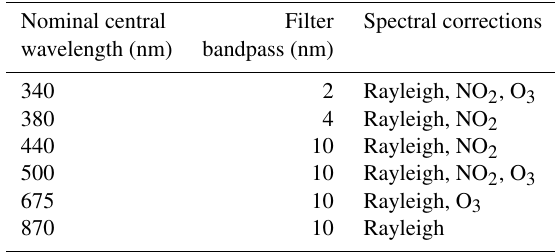
Table 2. Wavelengths characteristics of Cimel and spectral correc- tions used in the calculation of